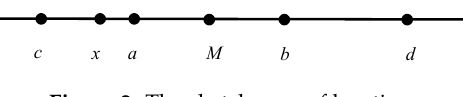
Figure 2. The sketch map of location